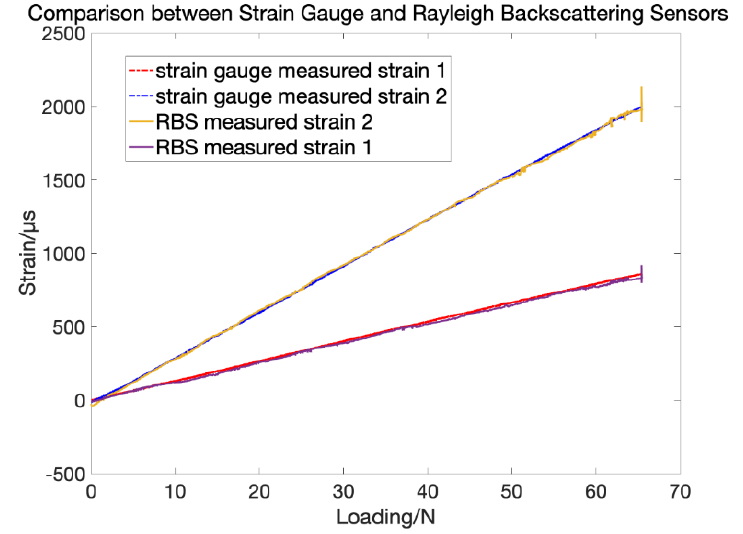
Figure 4. Strain measurement comparison between Rayleigh backscattering sensors and strain gauges.